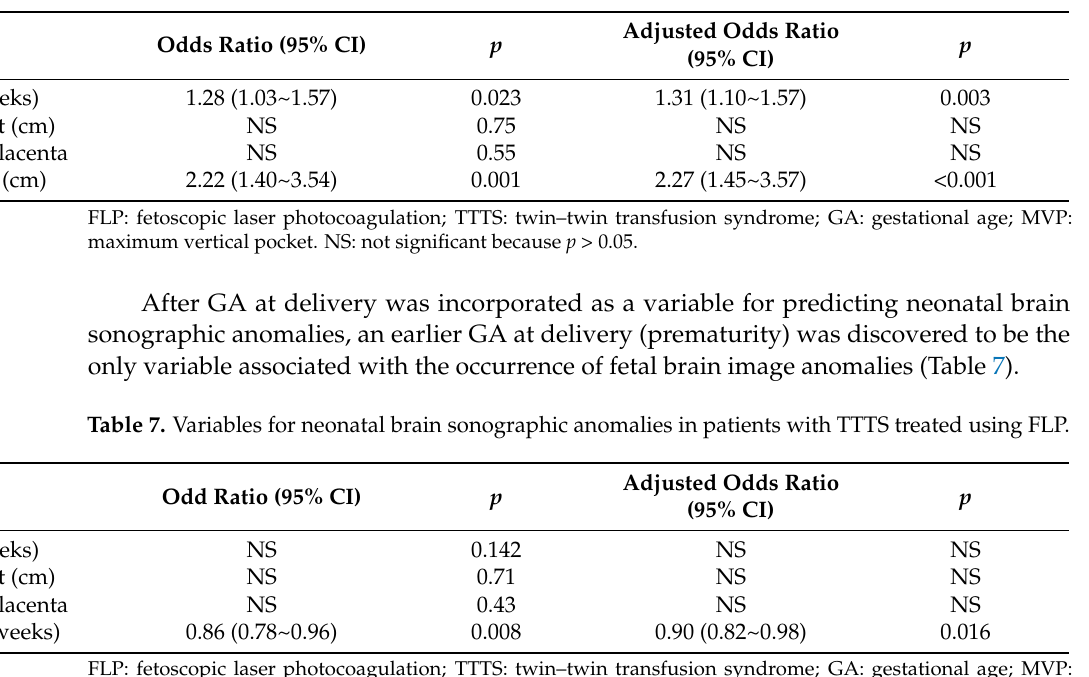
Table 6. Antenatal variables for the survival of one twin after FLP in severe cases of TTTS.